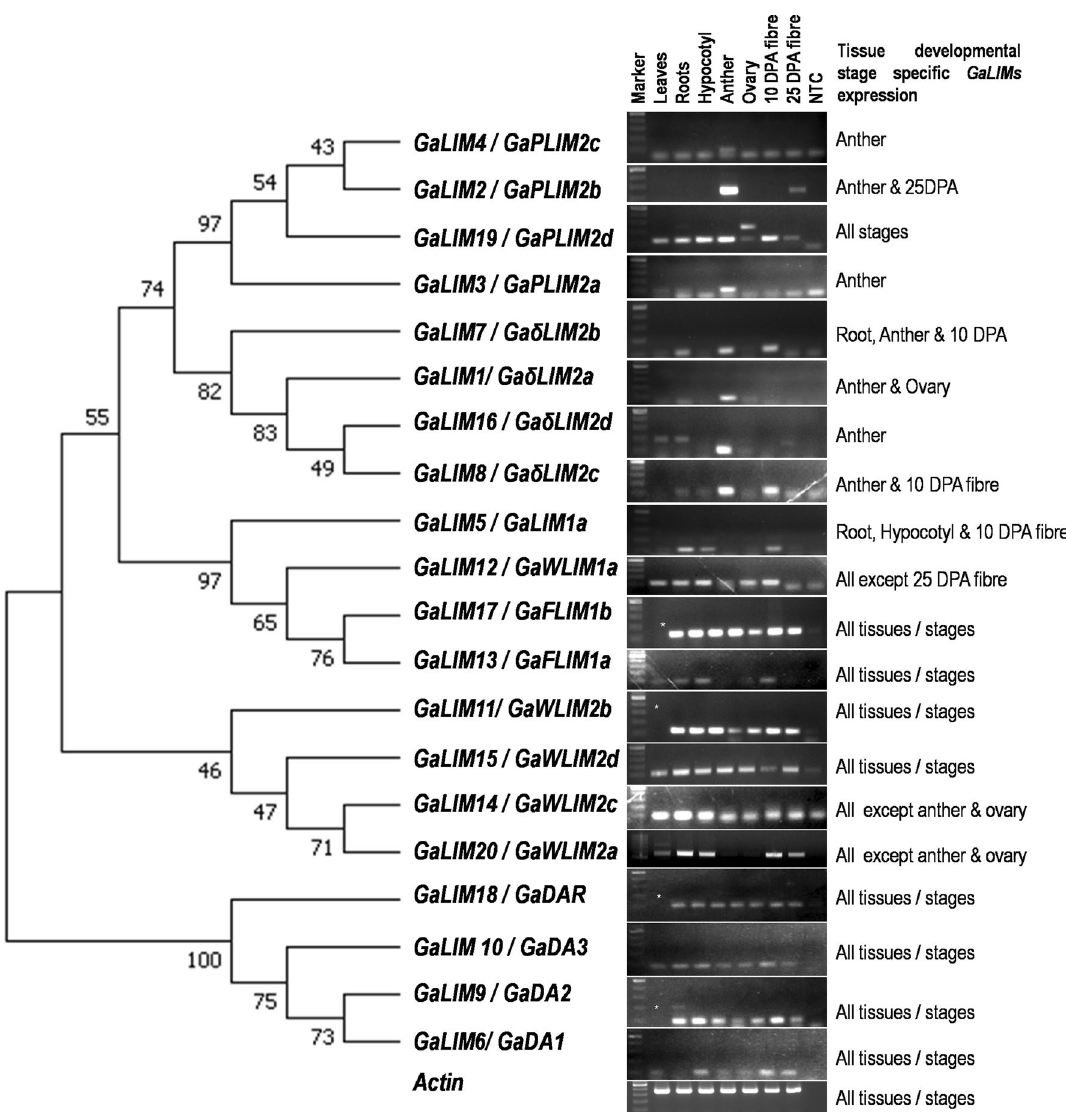
Figure 4. RT-PCR showing organ-specific expression of LIM genes in G. arboreum. (*denotes blank lane; Full- length gels are presented in Supplementary Figure